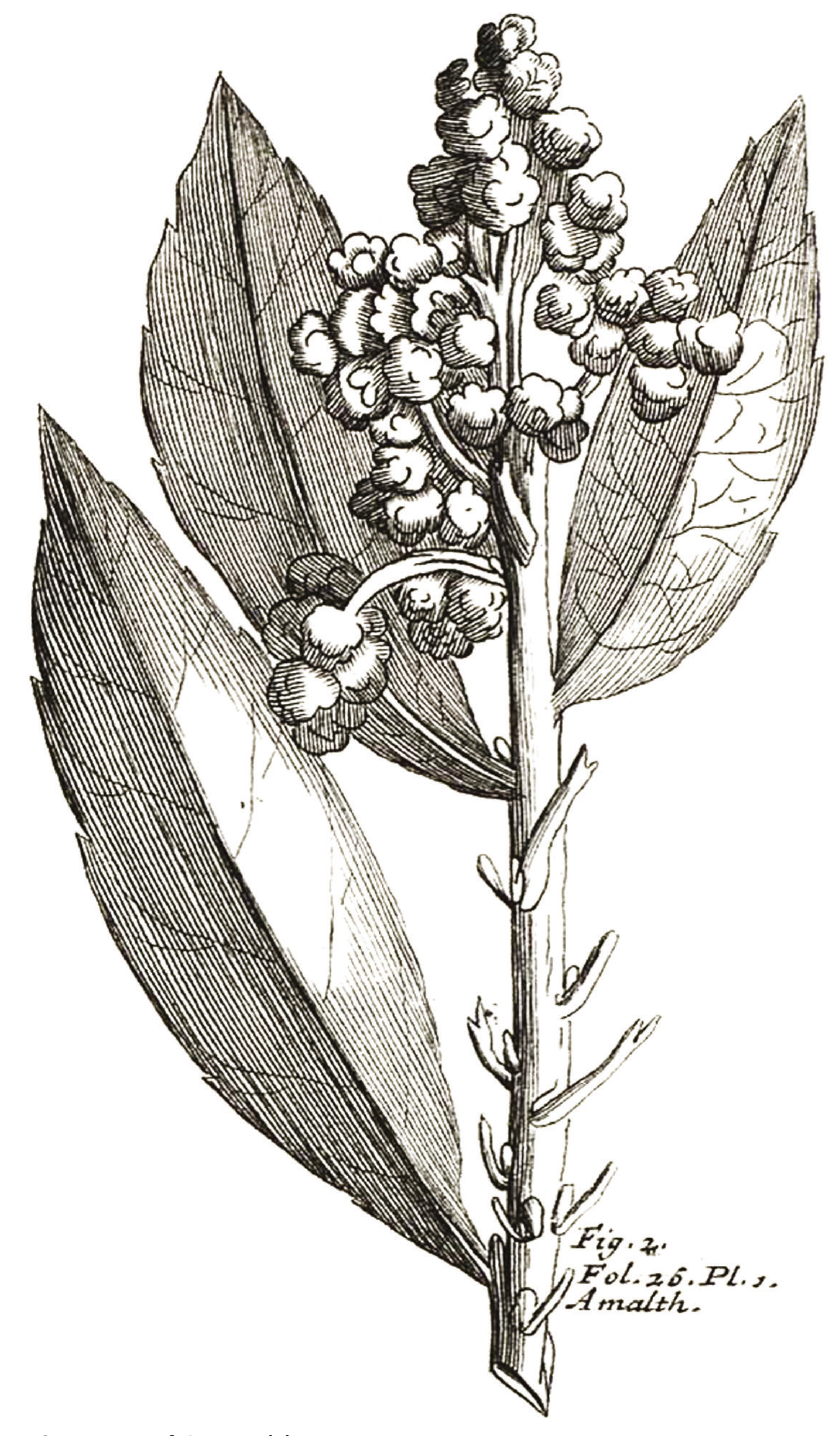
Figure 1. Lectotype of Crataegus bibas